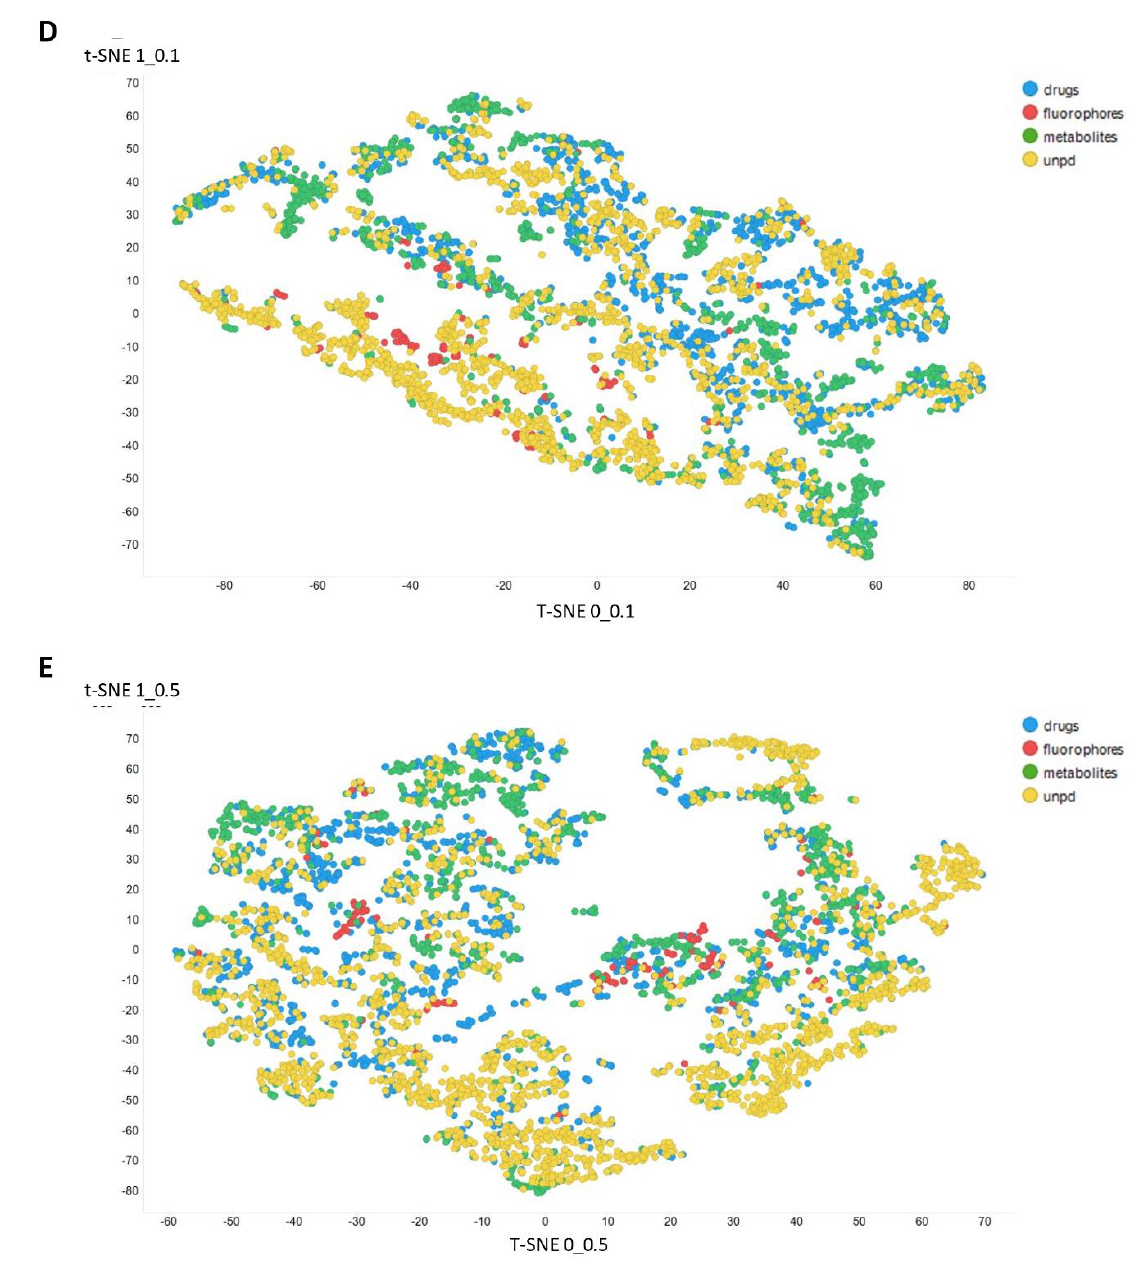
Figure 3. Effect of adjusting the temperature parameter in the contrastive learning loss on the distribution of molecules in the latent space as visualized via the t-SNE algorithm. For clarity, only a random subset of 2000 natural products is shown. ( A ) Learning based purely on the cross-entropy objective function. ( B – E ) The temperature scalar (as in [112]) was varied between 0.02 and 0.5 as indicated. (Reducing t below led to numerical instabilities.) All drugs, fluorophores, and Recon2 metabolites are plotted, along with a randomly chosen 2000 natural products (as in [113]).